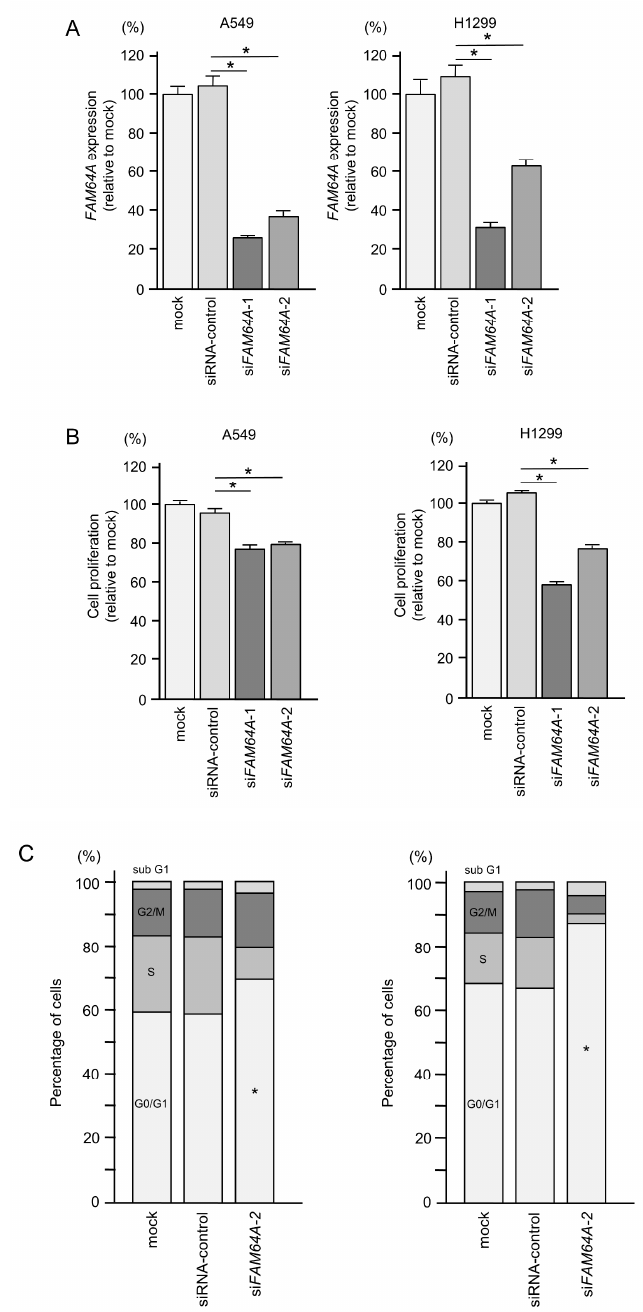
Figure 10. E ff ect of FAM64A knockdown on cell proliferation and cell cycle arrest in LUAD cells. ( A ) Successful suppression of FAM64A expression by si FAM64A -1 or si FAM64A -2 transfection in A549 and H1299 cells. ( B ) Cell proliferation assessed by XTT assay at 72 h after miRNA transfection (* p < 0.0001). ( C ) Flow cytometric analyses of cell cycle phase distributions in control cells and cells transfected with si FAM64A . The cells were assessed at 72 h after miRNA transfection (* p <